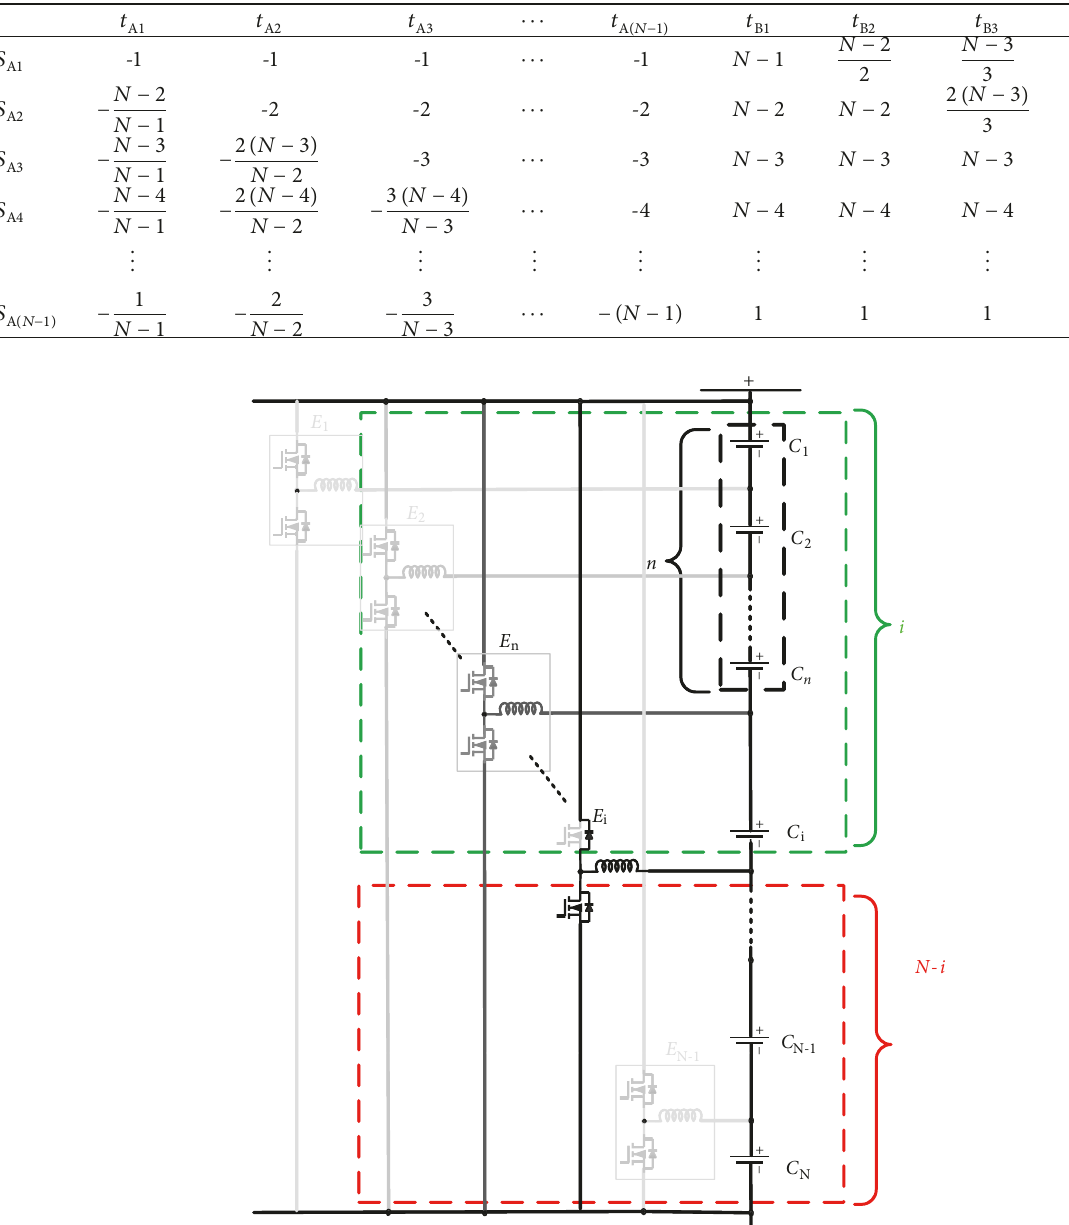
Table 1: Elements in the coefficient matrix K.